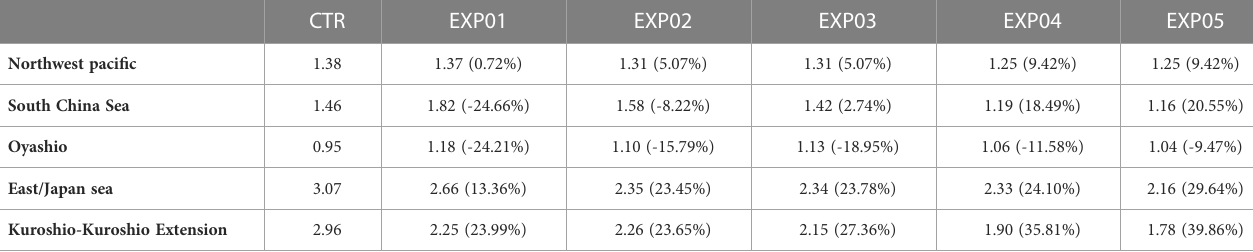
TABLE 3 RMSE averaged in space and time for temperature by region from all experiments.